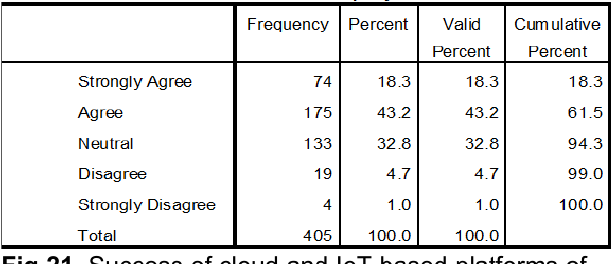
Fig 21. Success of cloud and IoT based platforms of the company has resulted in an increase in the company